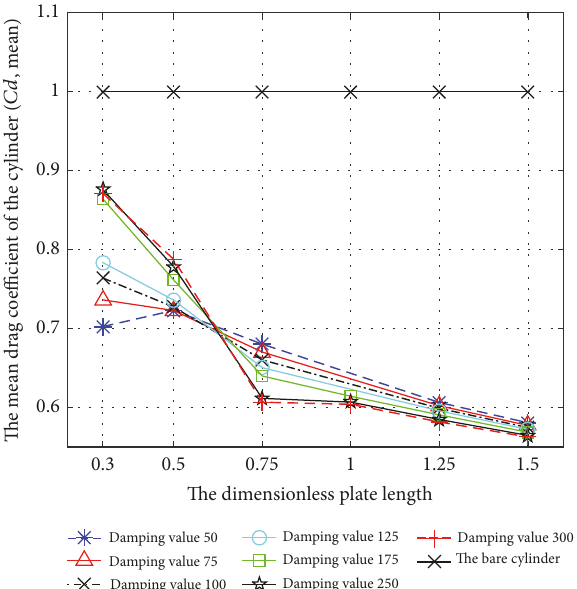
Figure 13: The variation of the drag coefficient (mean).